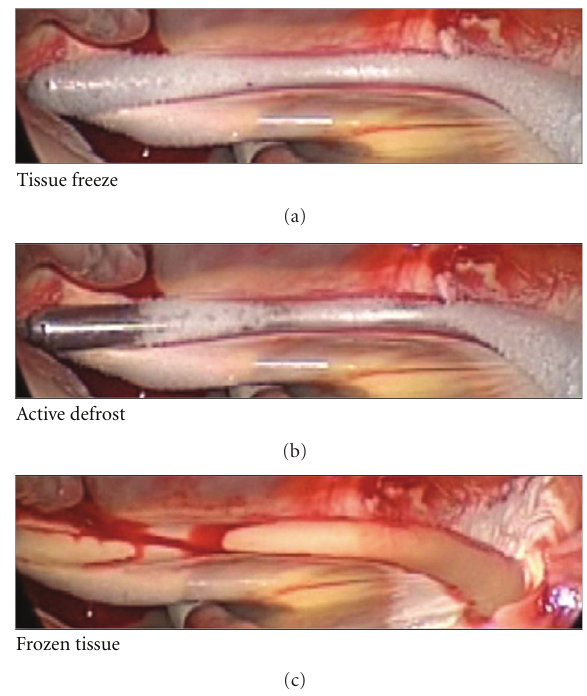
Figure 6: Freeze cycle of the CryoICE TM